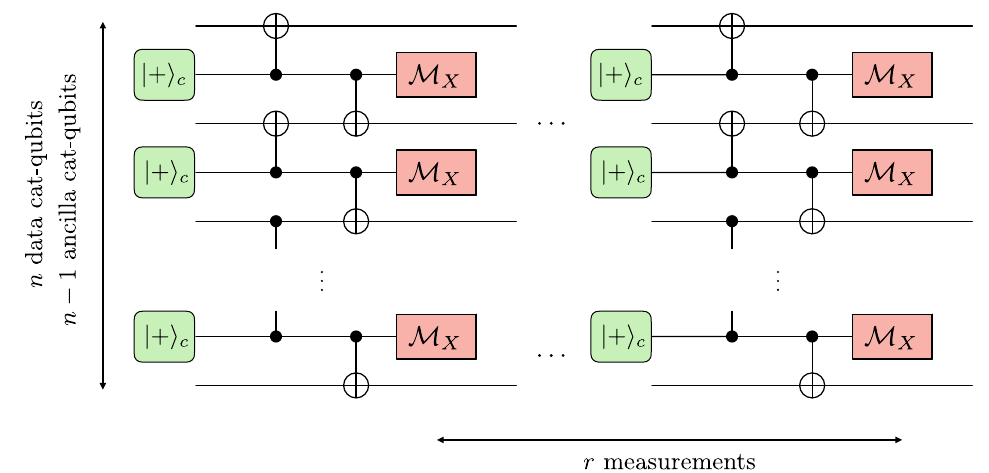
FIG. 6. Quantum error correction circuit for a repetition cat qubit. One repetition cat qubit, composed of data cat qubits and ancilla cat qubits (in green), is protected from errors by performing r rounds of error